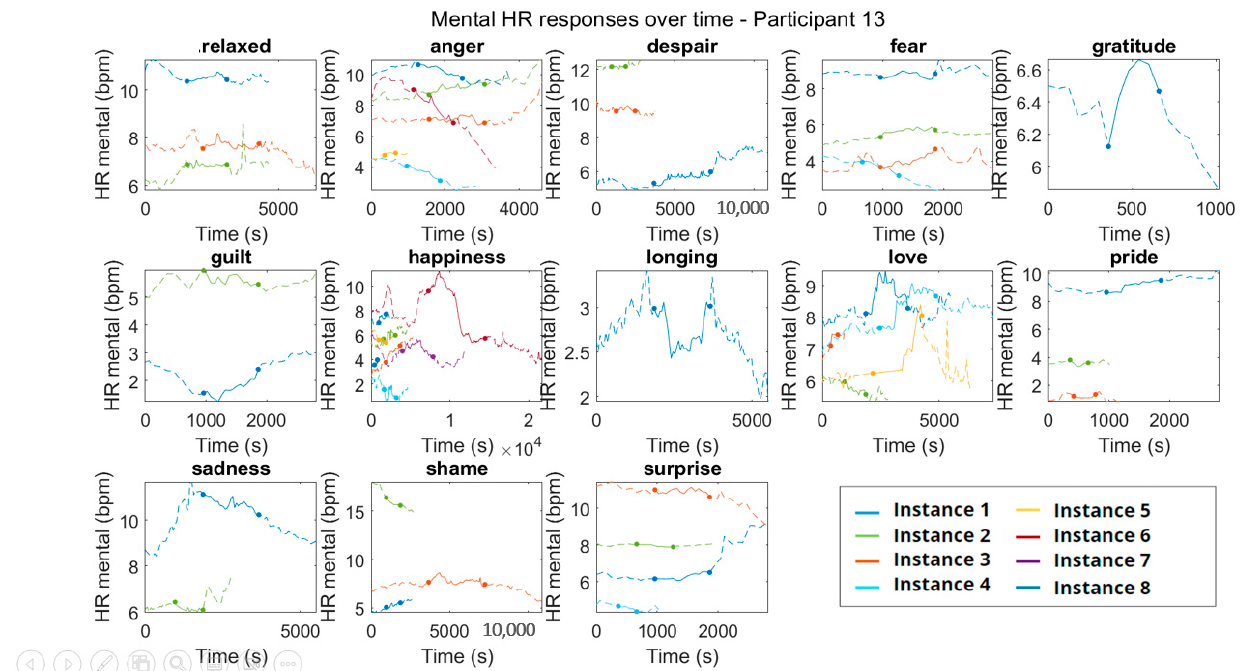
Figure 5. Example of response of the pre-processed mental HR component in function of time for each emotion (solid line) of participant P13. Each colour represents a different event of that specific emotion. The dotted lines are the mental HR response right before and after the emotion.